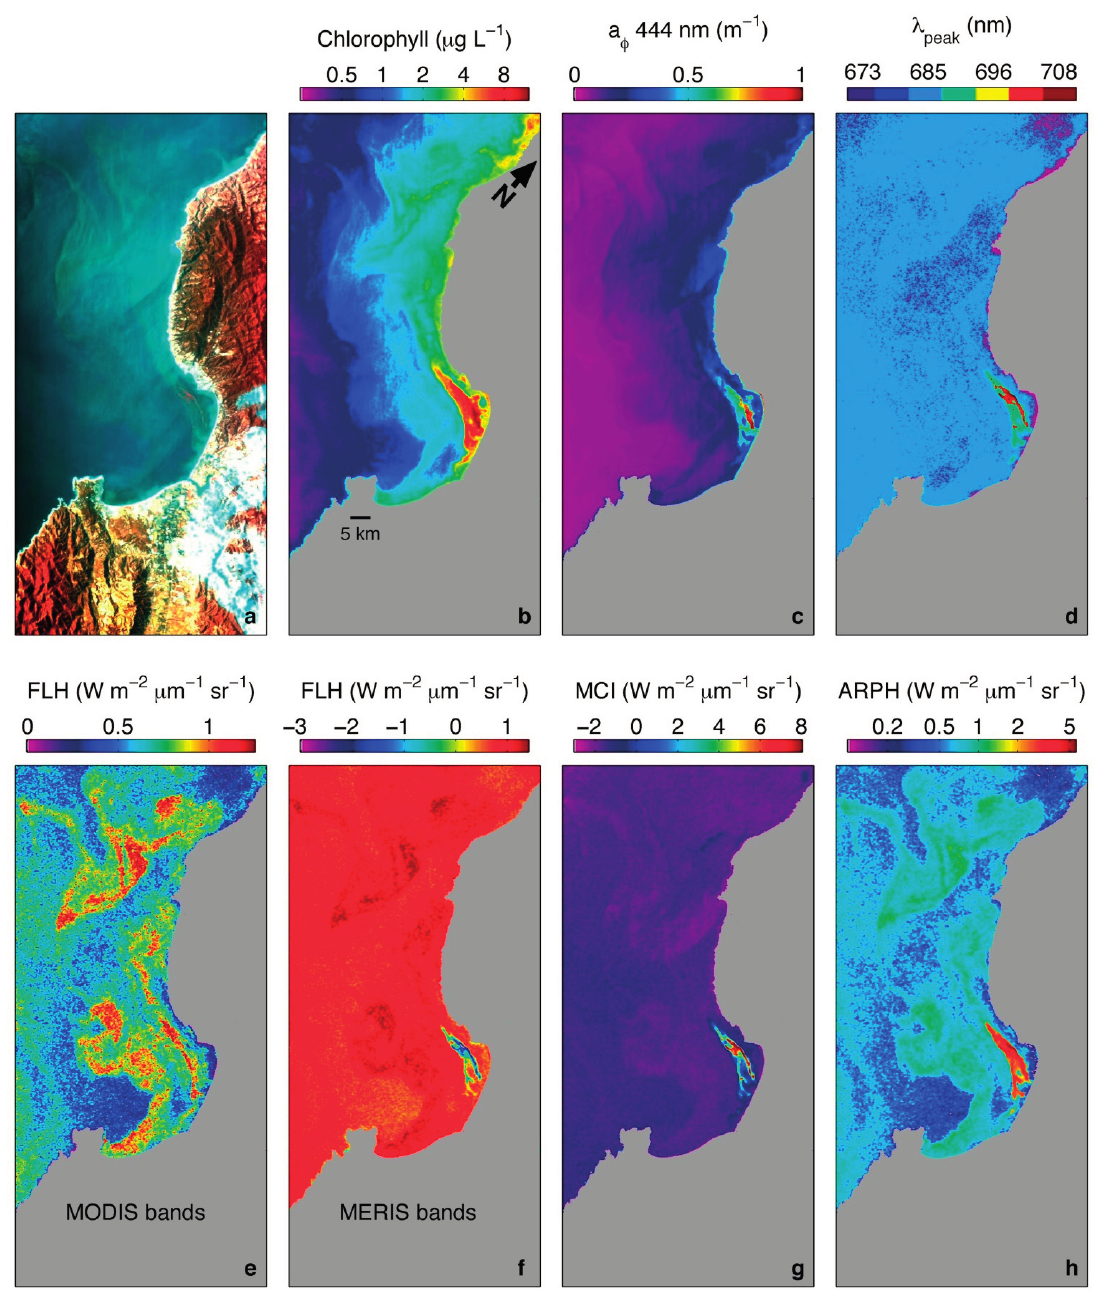
Figure 11. Phytoplankton characterization from a suite of algorithms. The HICO image was acquired on 6 November 2012. The enhanced color image ( a ) used bands centered at the 466 nm (blue), 554 nm (green), and 708 nm (near infrared, to emphasize signal of the red